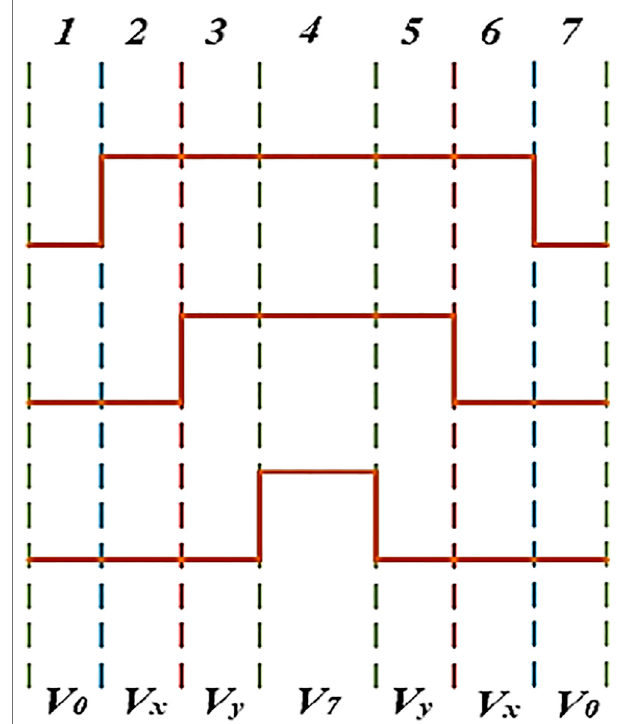
FIGURE 2 | One cycle of switching in